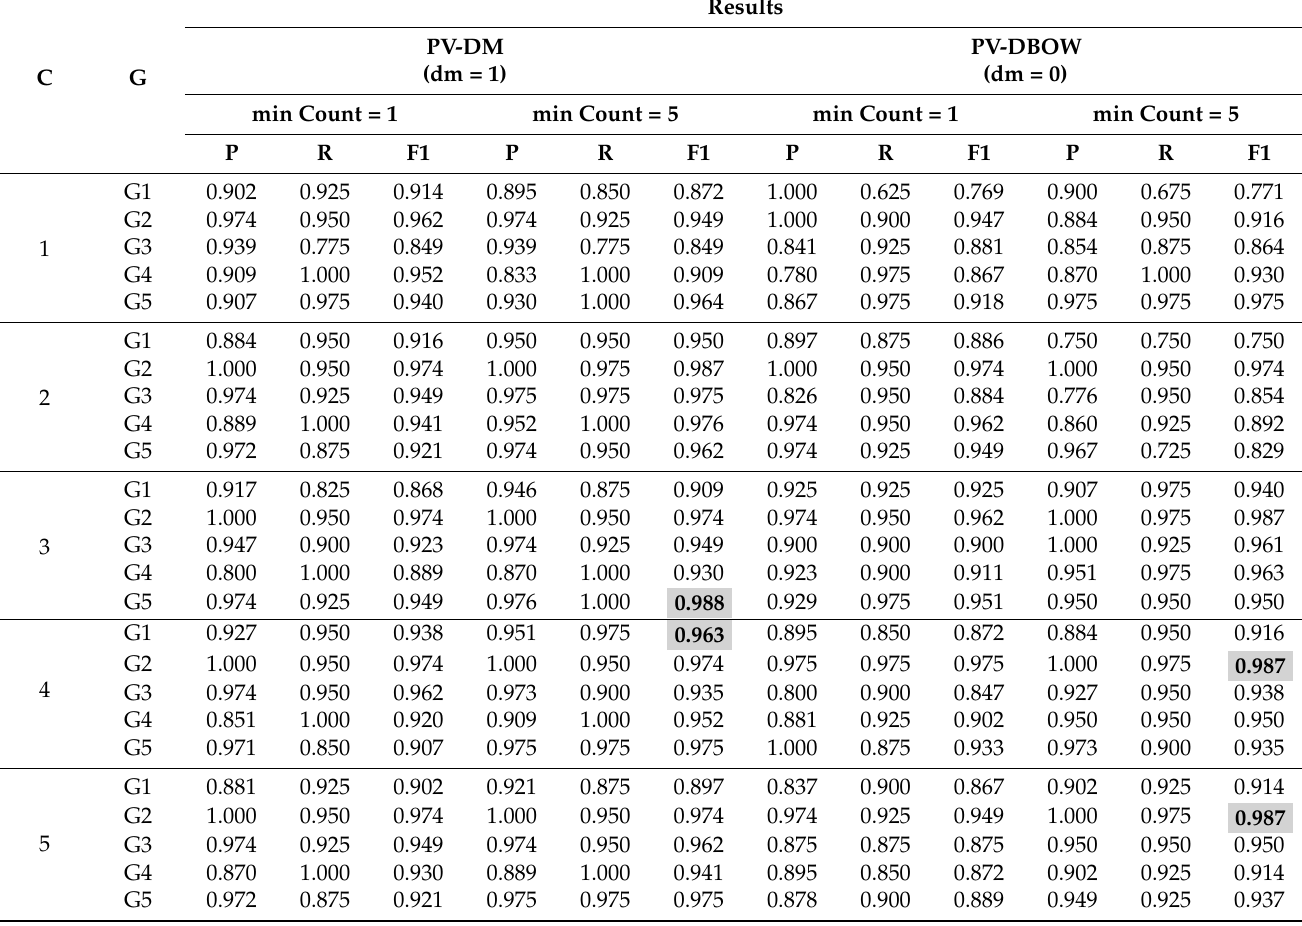
Table A3. Detailed scores of Experimental setup #2.